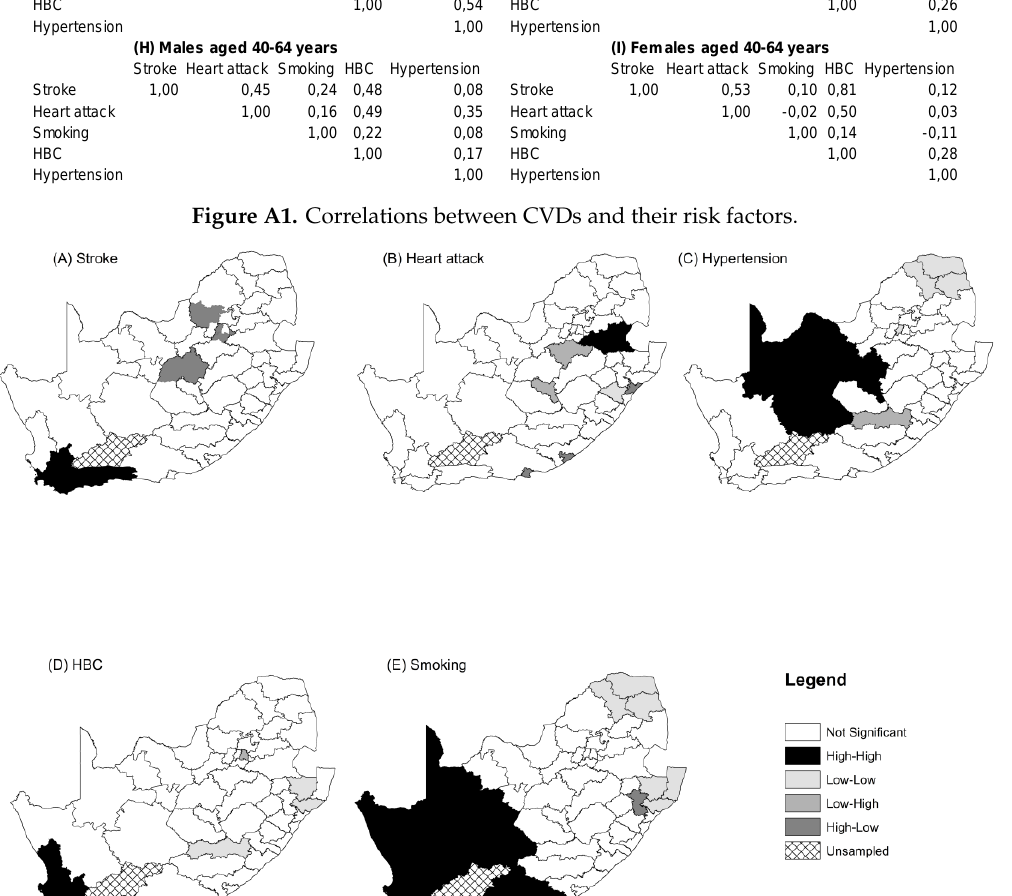
Figure A3. Spatial Clusters of Prevalence of five CVDs and their risk factors.